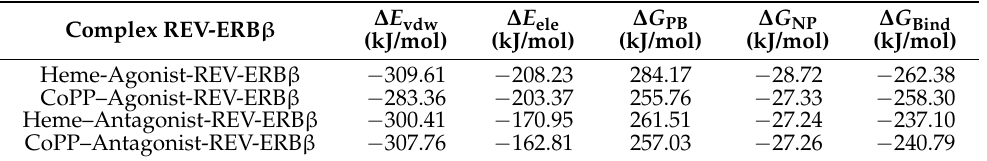
Table 2. The free binding energies and their corresponding components for protoporphyrin IX binding to REV-ERB β .